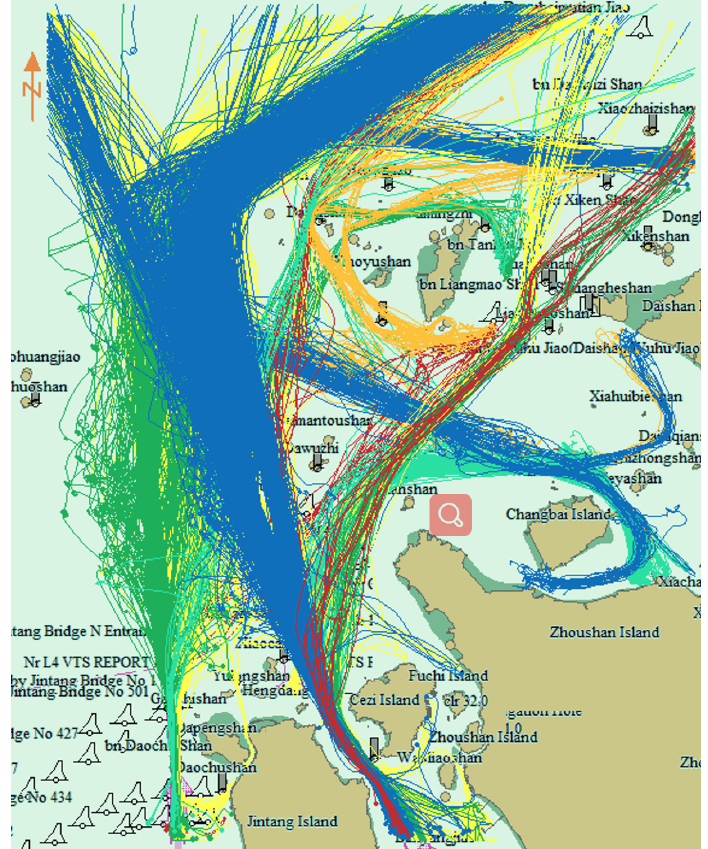
Figure 14. Cluster result using DBSCAN. After the construction of Yushan bridge, the clusters cross the Yushan bridge still exist, although no ships cross.